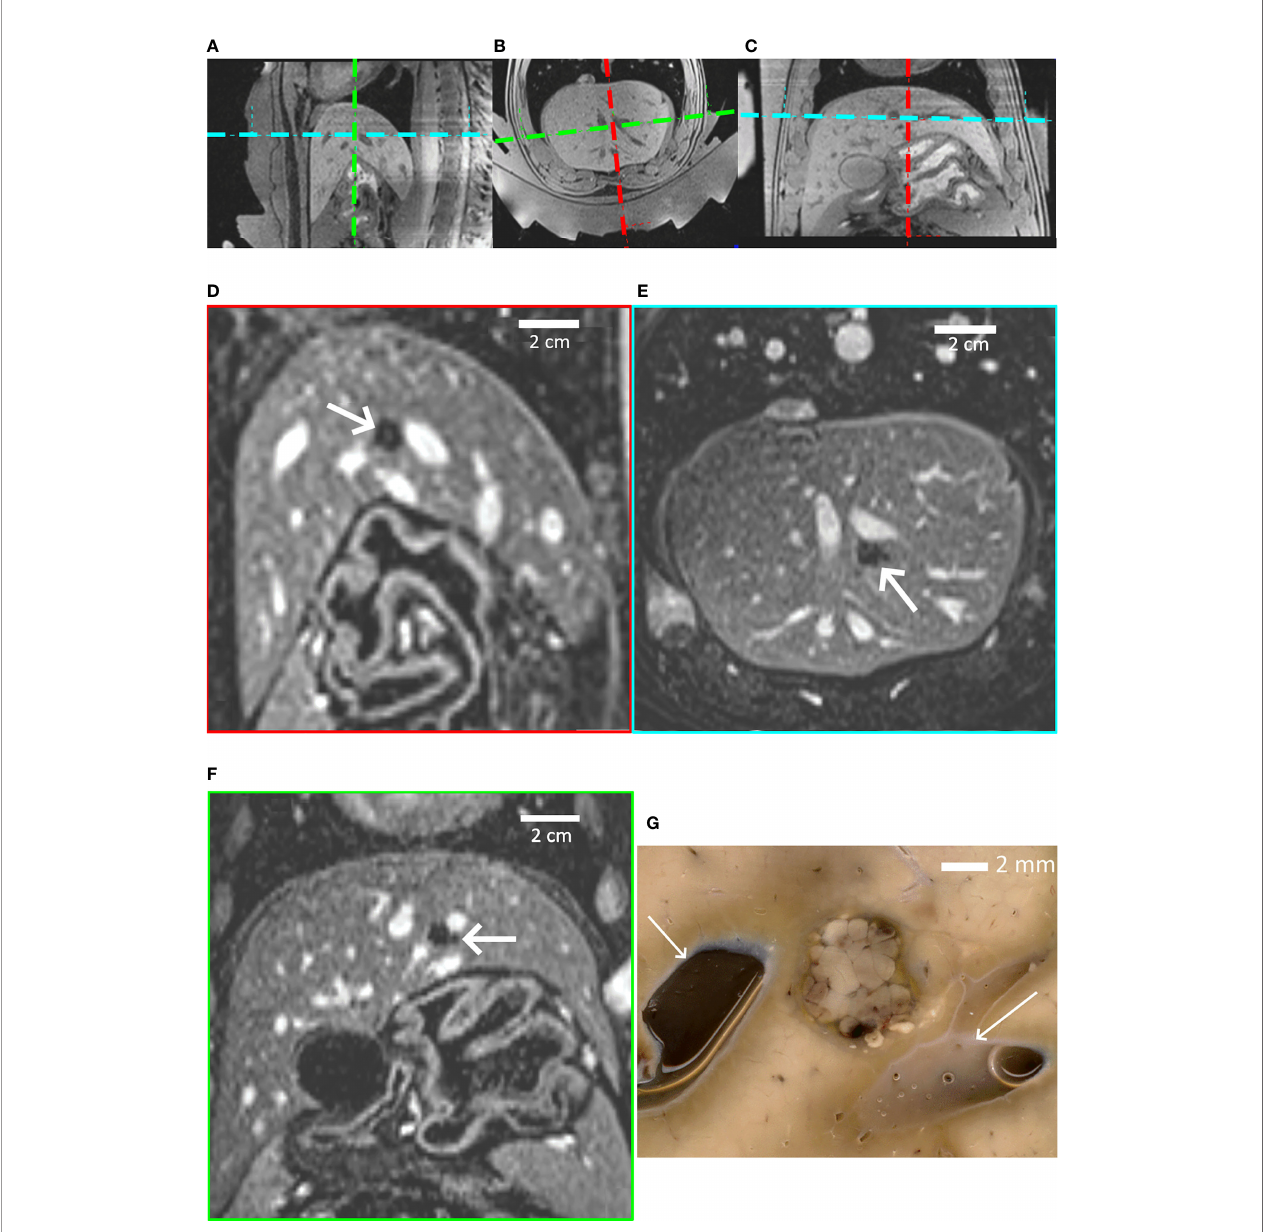
FIGURE 6 | Highlights of pig #1 experiment. (A – C) In-situ targeting based on high-resolution 3D T1w MR images. Three orthogonal sections are shown. The thermal lesion is prescribed at the crossing point of the transducer ’ s symmetry axes, visualized with colored dashed lines. (D – F) Post-intervention Gd-enhanced MR images illustrating the thermal lesion proximal to subhepatic veins in the sagittal, axial and coronal plane; the FOV is 155 mm. (G) Post-mortem gross pathology of the lesion after formalin fi xation, con fi rming the well-de fi ned thermal ablation. White arrows indicate blood vessels. A distance scale is